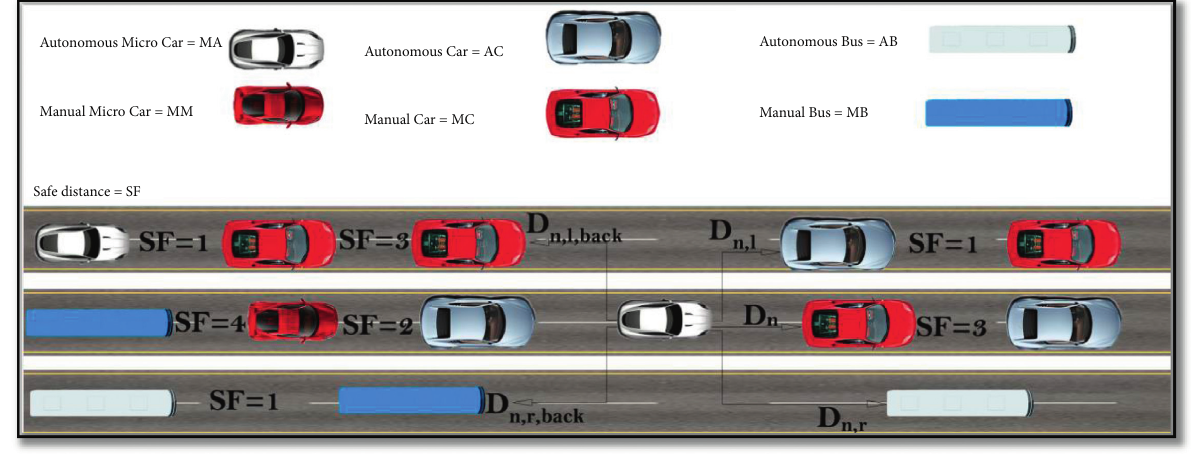
Figure 1: Schematic diagram of the